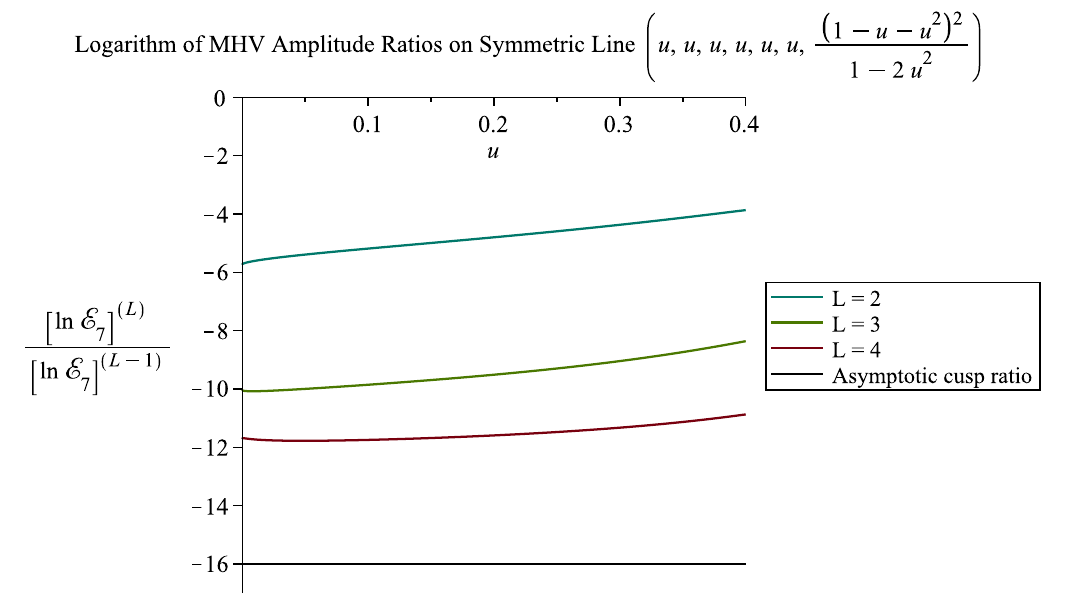
Figure 2 . Ratios of logarithms of the BDS-like normalized MHV amplitude E 7 at successive loop orders, on the diagonal line where u 1 = (cid:1) (cid:1) (cid:1) = u 6 = u